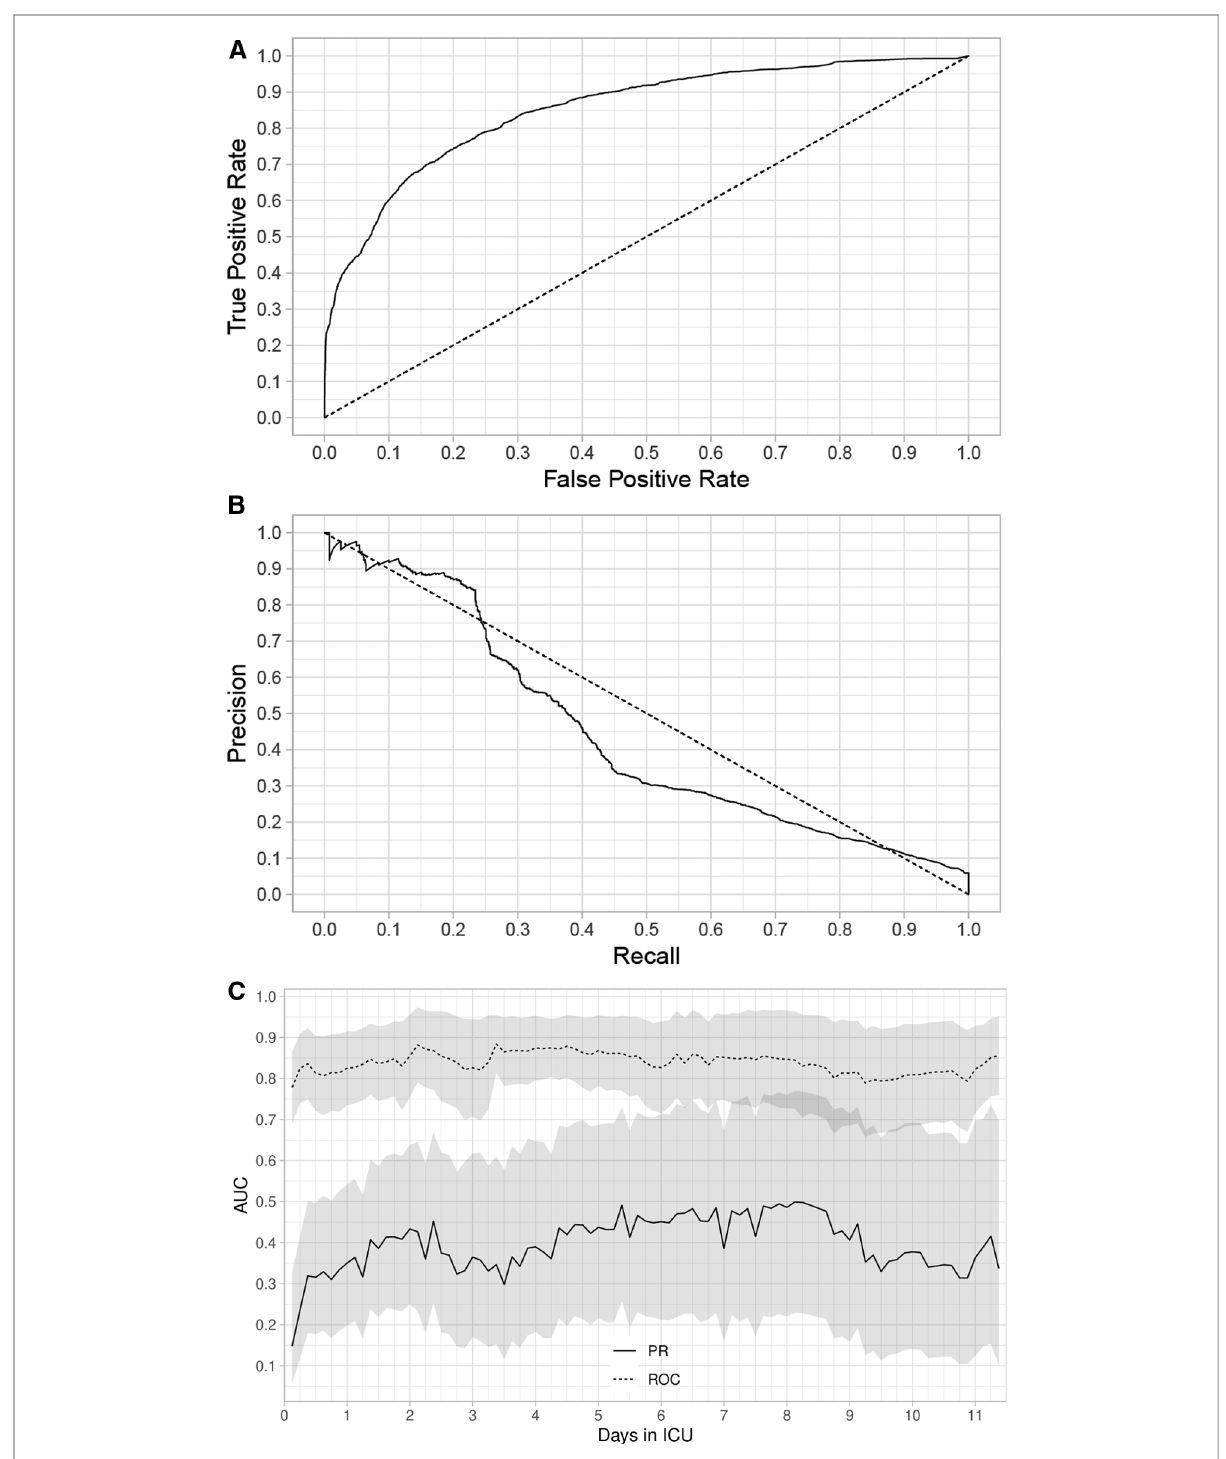
FIGURE 1 Area under the receiver operating characteristic (AUROC) curves (A), area under the precision recall (AUPRC) curves (B), and AUROC and AUPRC computed every 3 h. Outcomes were survival and death. ( A ) The AUROC for all time periods through 11.4 days. ( B ) The AUPRC for all time periods through 11.4 days. ( C ) AUROC and AUPRC calculated every 3 h through 11.4 days. The shaded regions are pointwise 95% con fi dence intervals. We applied boost strap techniques to the test set with 5,000 strati fi ed bootstrap replicates to compute the con fi dence